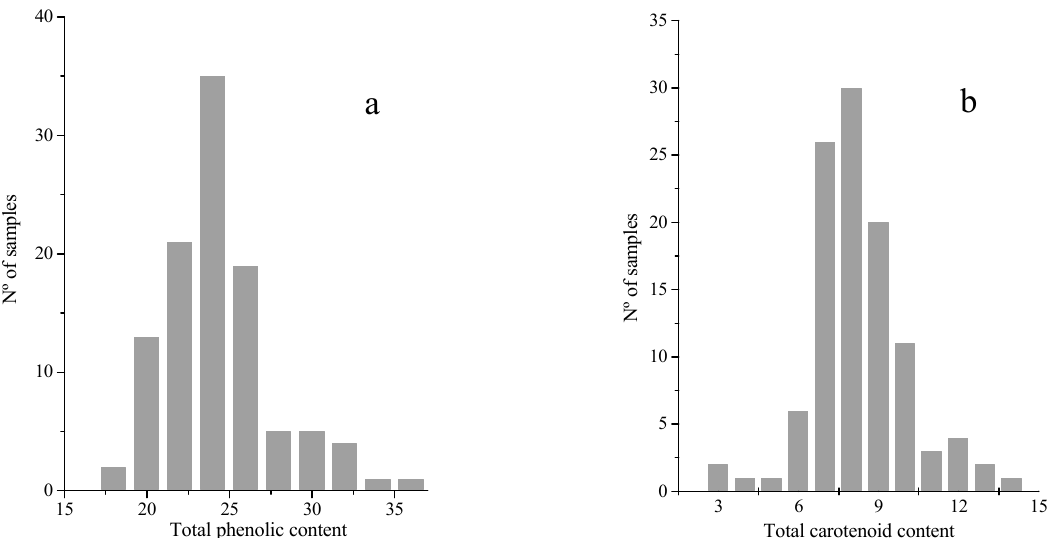
Figure 1. Frequency distribution plots for total phenolic ( a ) and total carotenoid content ( b ) by reference analysis.